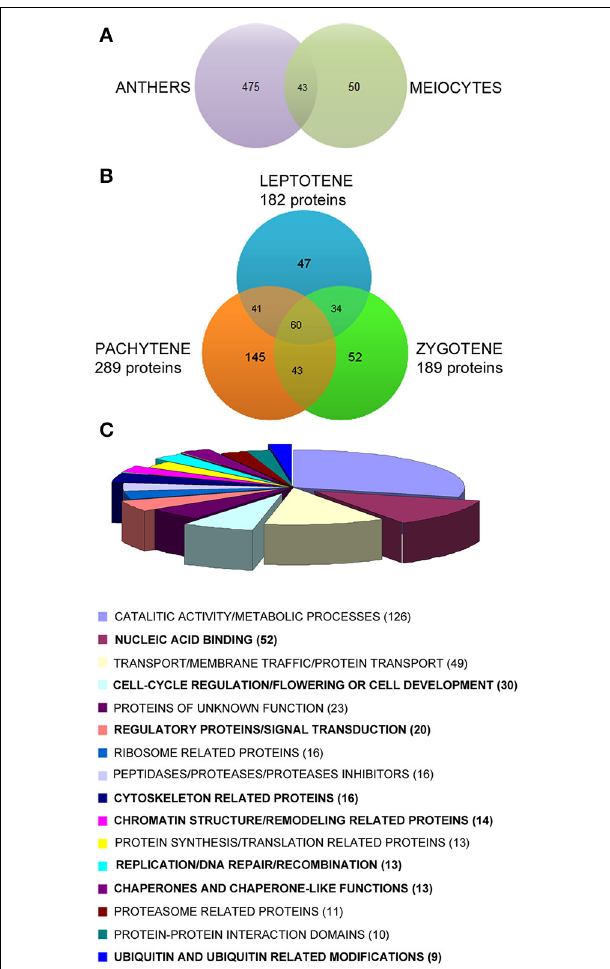
FIGURE 4 | (A) Venn diagram of preliminary experiments comparing the proteins identified in a pull of full anthers and a pull of isolated meiocytes in meiosis (mix of different stages). (B) Venn diagram representing the proteins identified in rice meiocytes at early prophase I (leptotene, zygotene, and pachytene). The proteins identified at later stages (diplotene and diakinesis) were subtracted. Only peptides with 5–30 amino acids and a minimum of two peptides per protein were used for positive identification, and peptide FDR < 0.01. (C) Diagram of the biological functions associated to the 422 proteins identified only at early prophase I stages. The numbers of proteins associated to each function are in